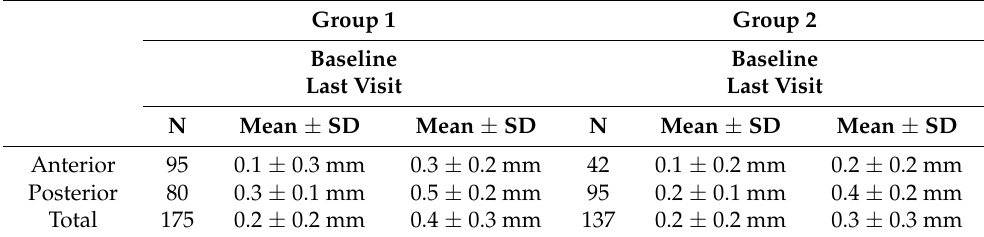
Table 4. MBI change for different groups (Group 1: EA > 30 ◦ ; Group 2: EA ≤ 30 ◦ ). N: number of implants; SD: Standard Deviation.